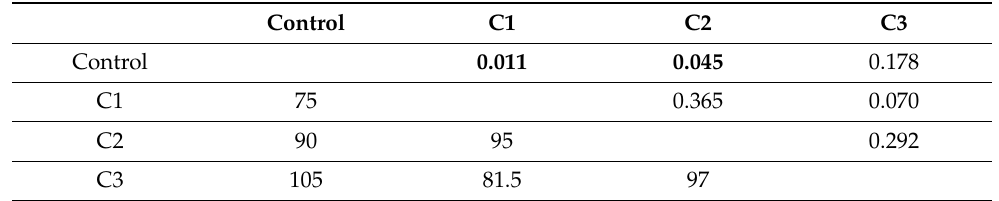
Table 2. Pairwise Mann–Whitney test results ( p value above, U value below). Significant differences marked in bold.